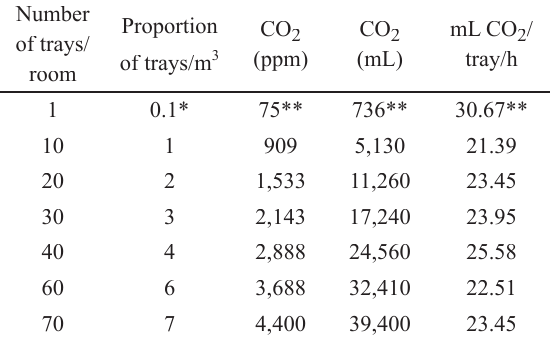
Concentration of CO (ppm) produced by trays 2 of A. kuehniella , inside the rooms of 9.79 m 3 , the amount of CO into the rearing rooms (mL) and the 2 amount of CO produced per tray per hour (mL): 2 Temperature: 25 ± 3°C, photophase: